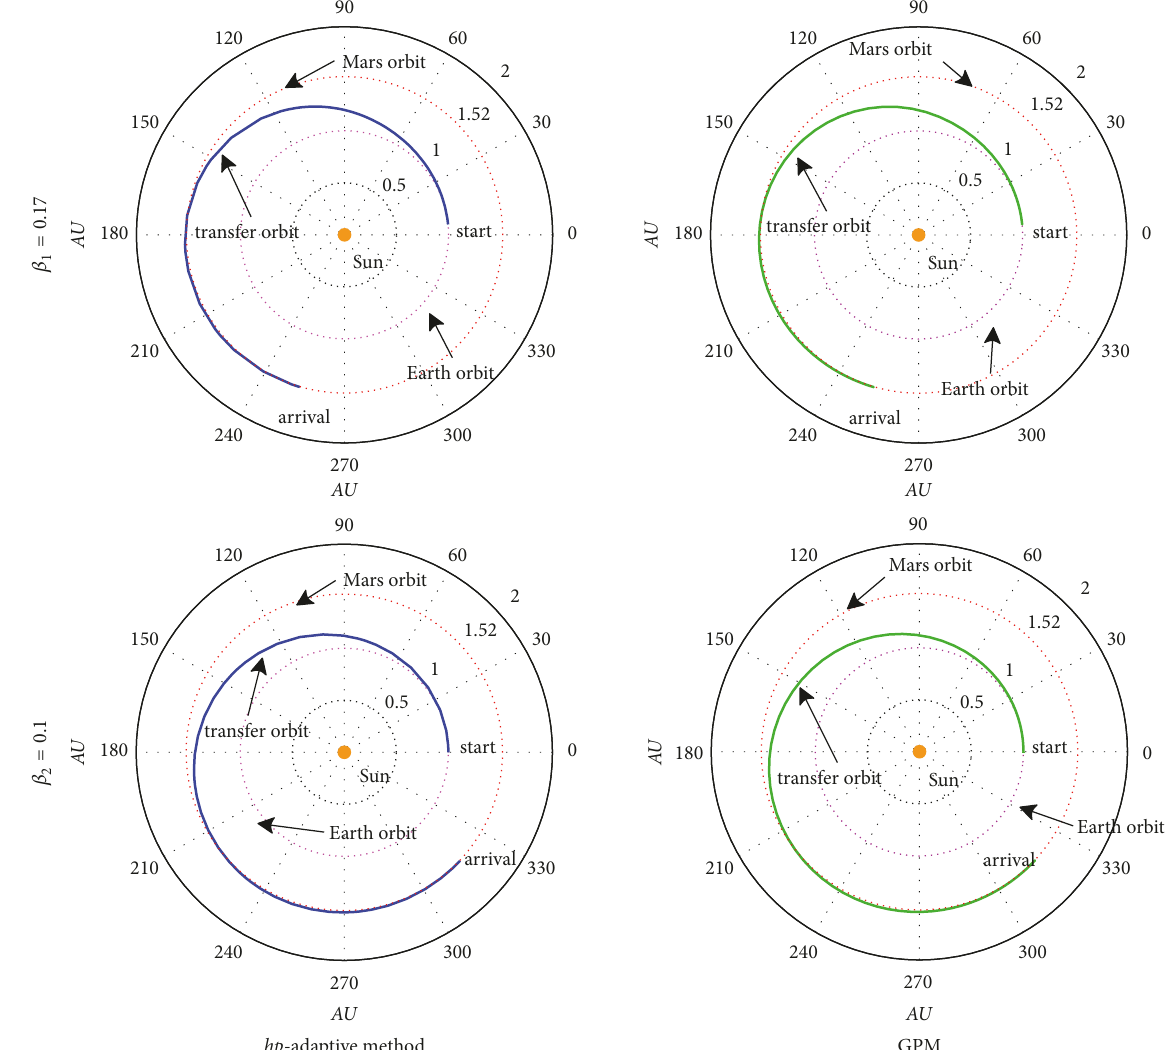
Figure 4: The optimized trajectory of the solar sail from Earth orbit to Mars